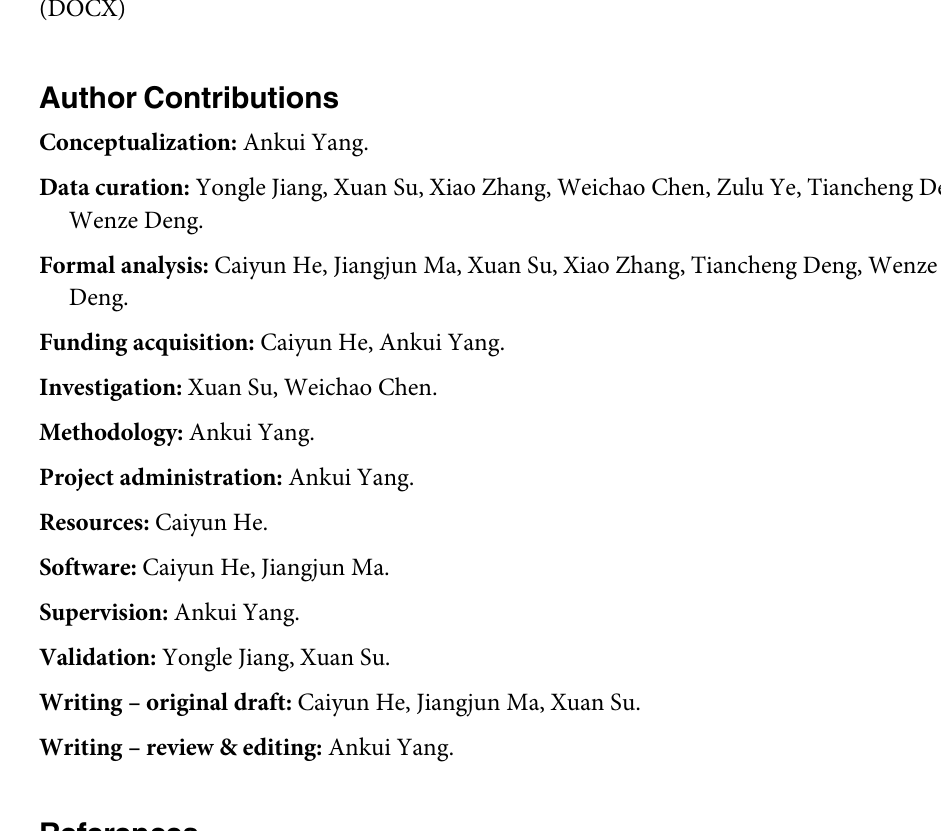
S1 Table. Measurement and distribution of the clinicopathological features of thyroid can- cer patients. S2 Table. Association between RET tagSNP and susceptibility to thyroid cancer in DTC patients without concomitant thyroid benign diseases. S3 Table. Association between RET tagSNP and susceptibility to thyroid cancer in DTC patients with concomitant